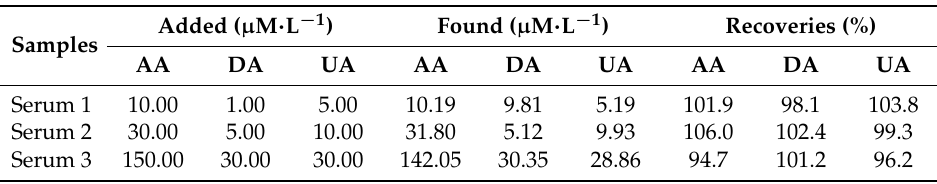
Table 2. Recovery of AA, DA, and UA in real samples ( n = 5).